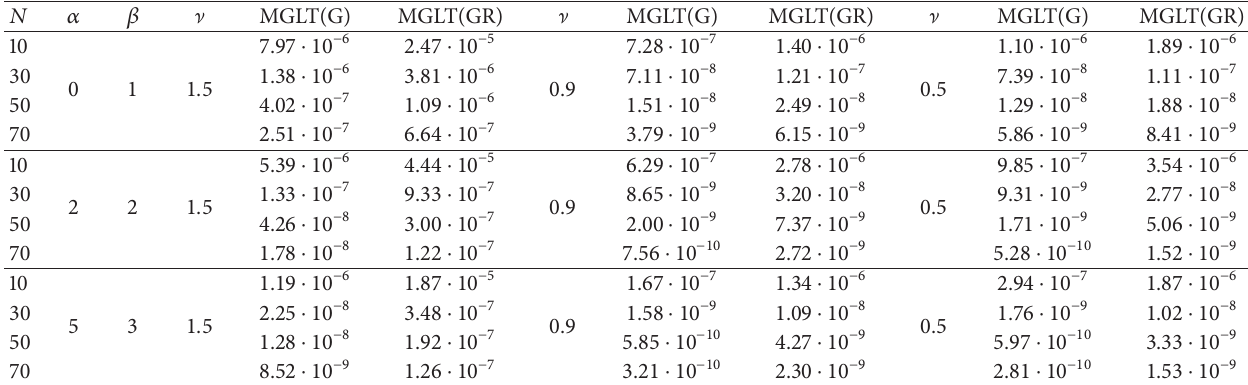
the maximum absolute errors using MGLT method with the treatment of right-hand side by modi- fied generalized Laguerre-Gauss and Gauss-Radau,